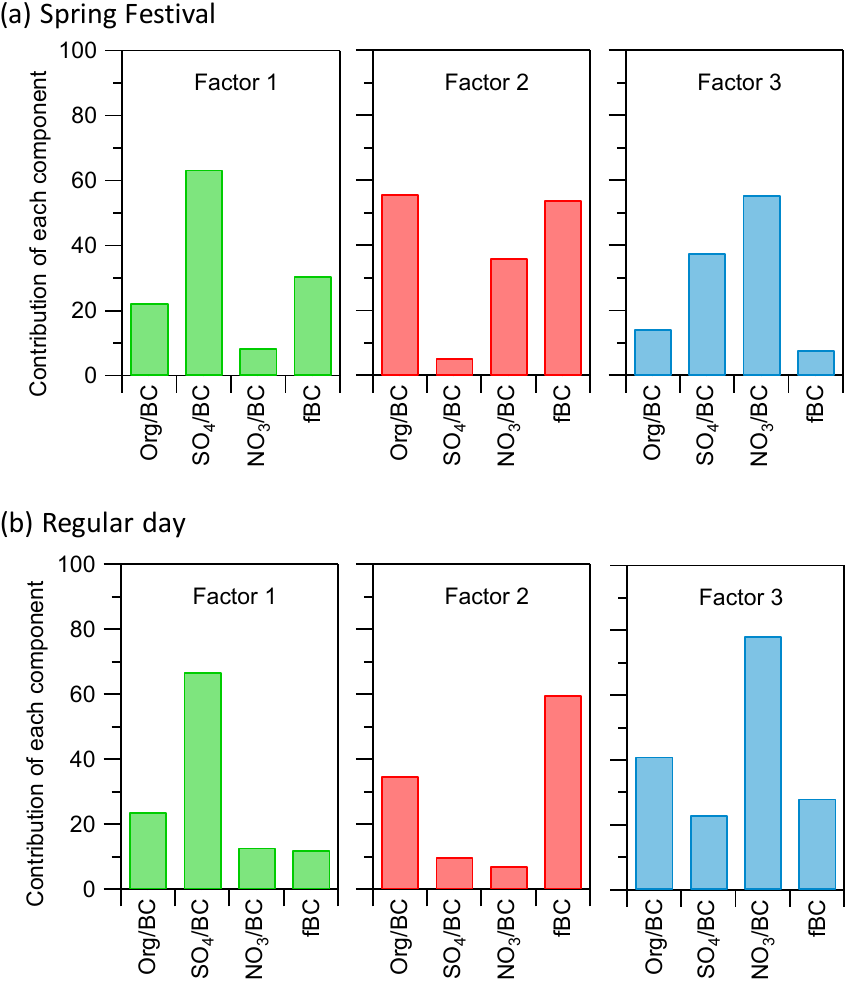
ff erent components for ( a ) spring festival and ( b ) regular Figure 5. Contribution of different components for ( a ) spring festival and ( b ) regular day. Figure 5. Contribution of di